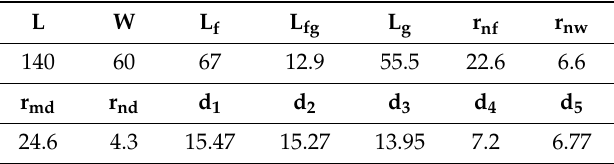
Table 2. Optimized parameters of the proposed antenna in